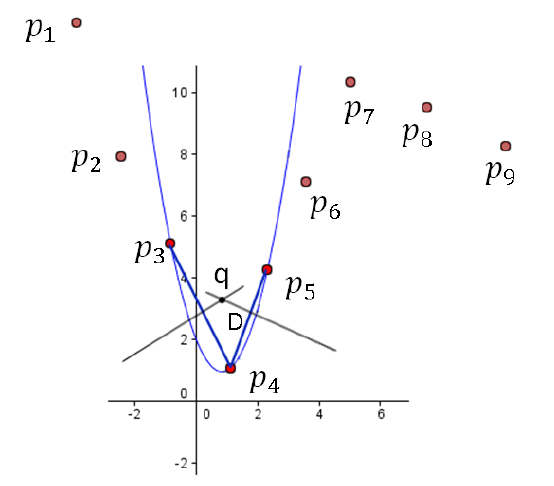
Figure 5. Approximation of the parabolic fit estimation